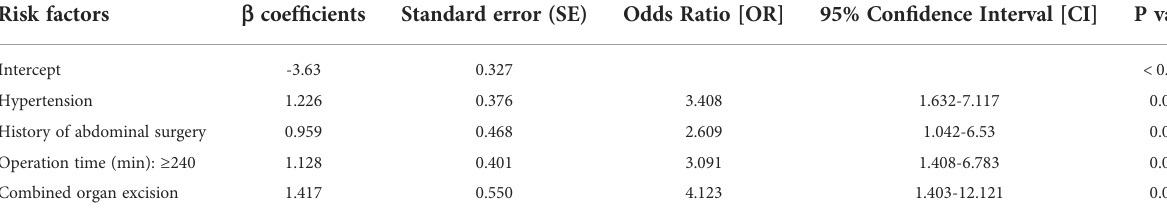
TABLE 4 Multivariate analysis of risk factors of IAI based on internal validation data.